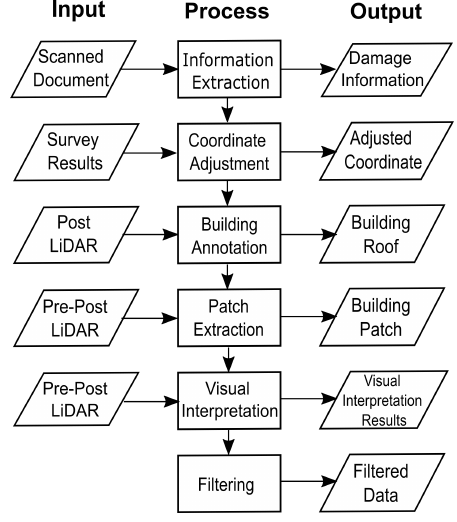
Figure 3. Dataset creation